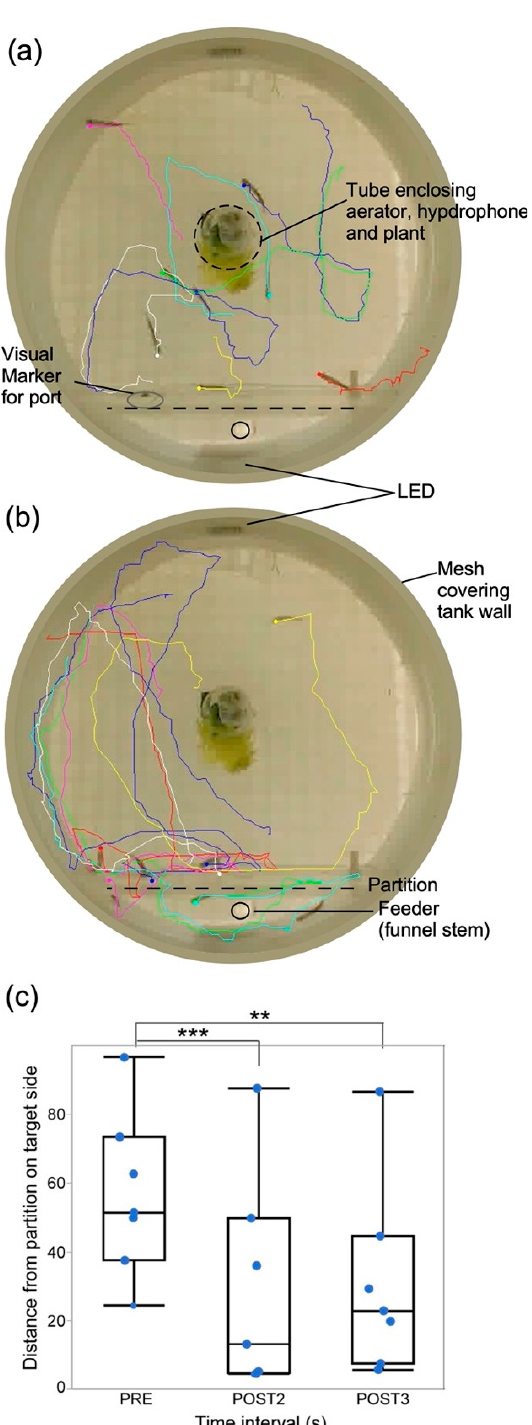
Figure 4. Tracking individual fish behavior. Tracks of swim paths of seven fish created using idTracker from video recordings ( a ) before, and ( b ) during presentation of a short, 4 s duration sound stimulus. Tracks begin at locations 1 s pre- and terminate 4 s post-sound onset. ( c ). Box plots and jittered scattergrams showing distances of fish (n = 6) from correct (target) side after training in response to the presentation of sounds within a single trial (4). Data were obtained from 1 s before (PRE) and during the second (POST2) and third (POST3) second post-stimulus. Shorter distances from target indicate better learning. On average, fish were closer to target during POST2 and started to wander away during POST3. ** indicate statistically significant and *** indicates highly significant